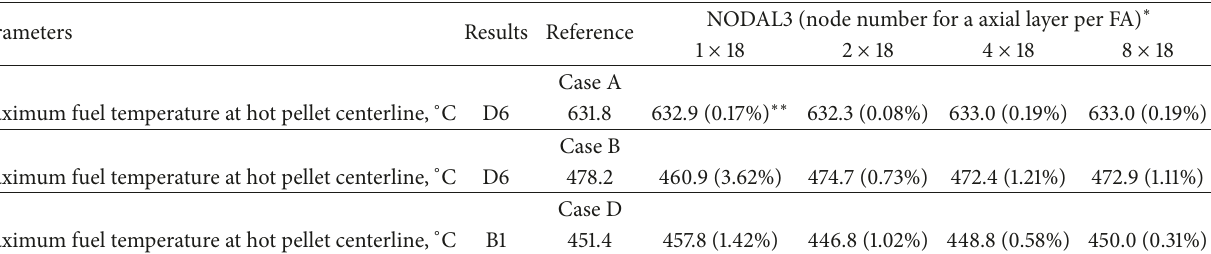
Table 9: Effect of axial nodes number per FA for transient hot pellet results in Cases A, B, and